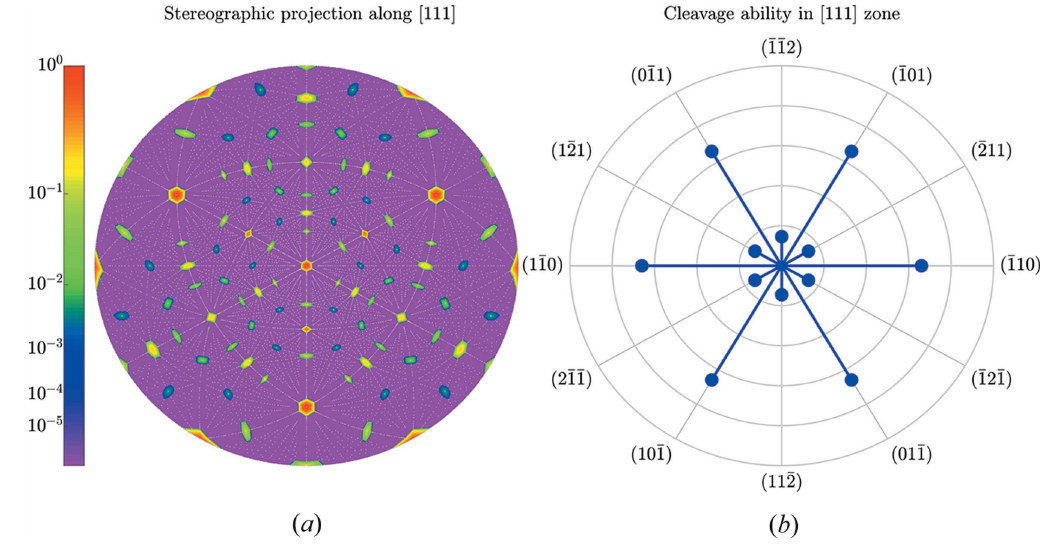
Figure 6 Same as Fig. 5 but for the [111] direction in silicon. The outer circle in ( b ) corresponds to the highest cleavage ability C 111 = 1.025 A˚ . Uriel Vaknin et al. (cid:5) Geometrical prediction of cleavage planes in crystal structures